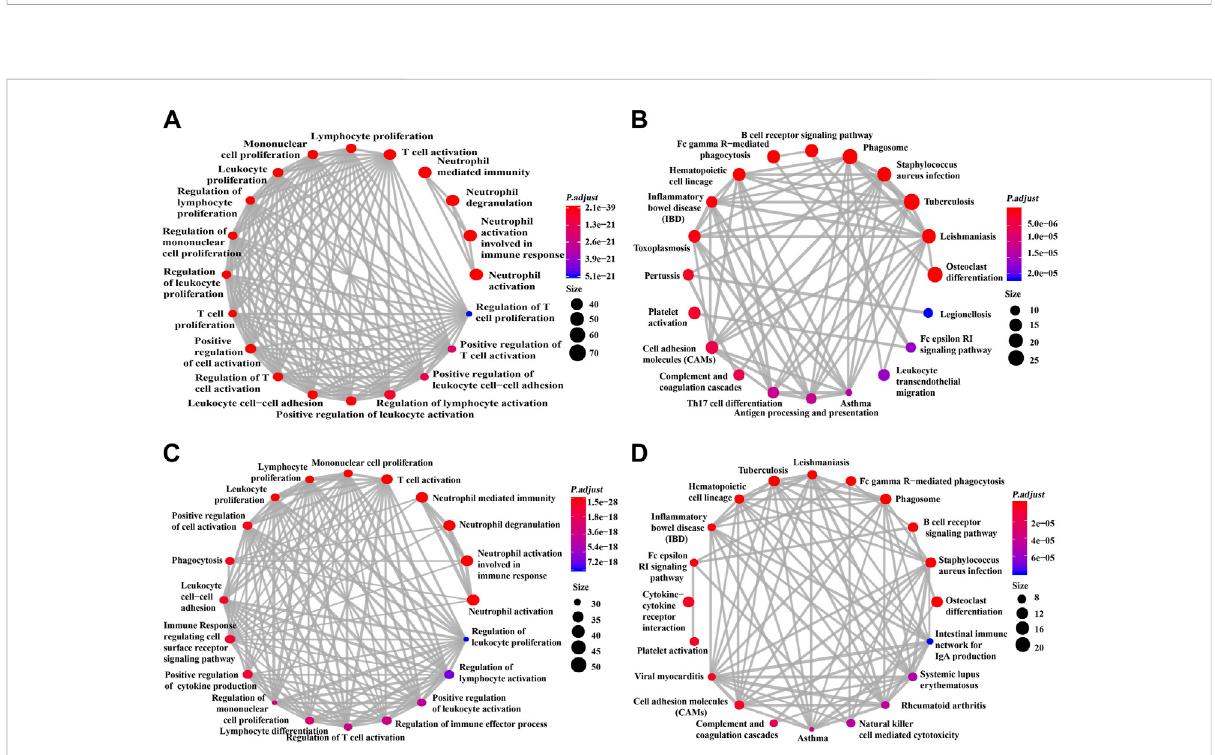
FIGURE 5 GO and KEGG signaling pathway analysis of siglec10-related genes. (A) GO analysis of siglec10-related genes with TCGA dataset. (B) KEGG signaling pathway analysis of siglec10-related genes with TCGA dataset. (C) GO analysis of siglec10-related genes with the CGGA dataset. (D) KEGG signaling pathway analysis of siglec10-related genes with the CGGA